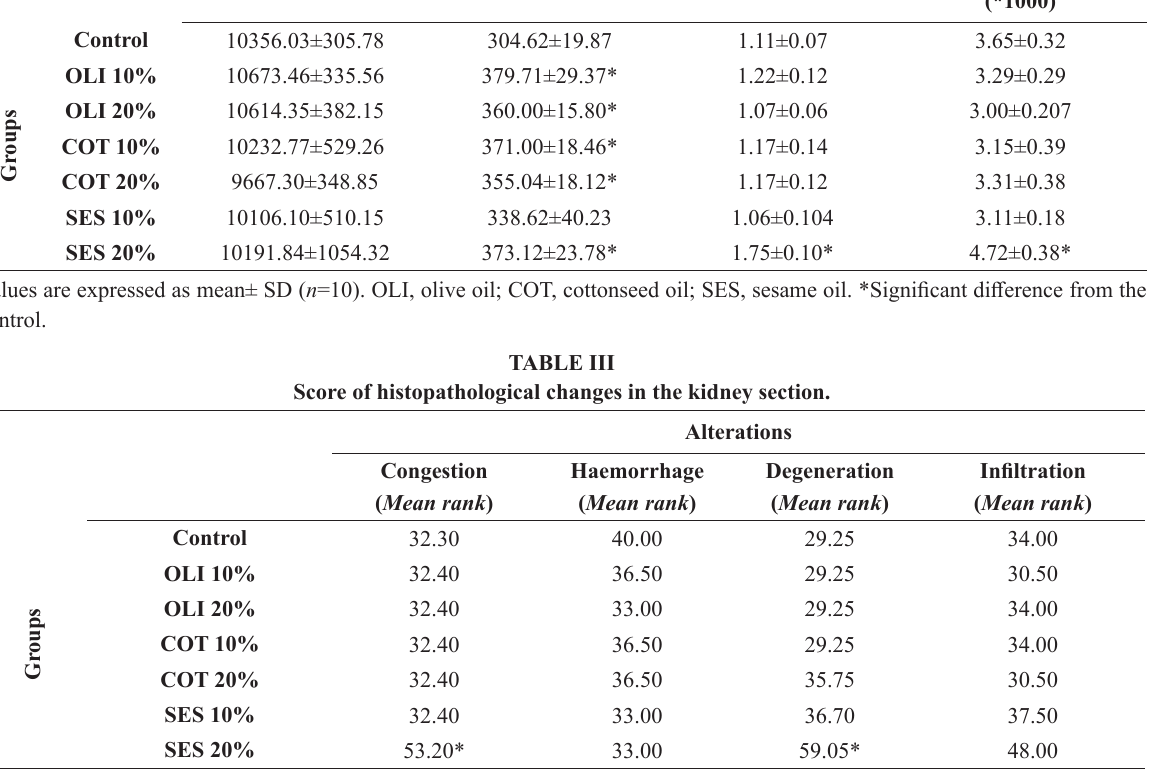
Total energy intake, body and kidney weights, and kidney to body weight ratio. Body weight Total energy intake (kcal/rat/5months)